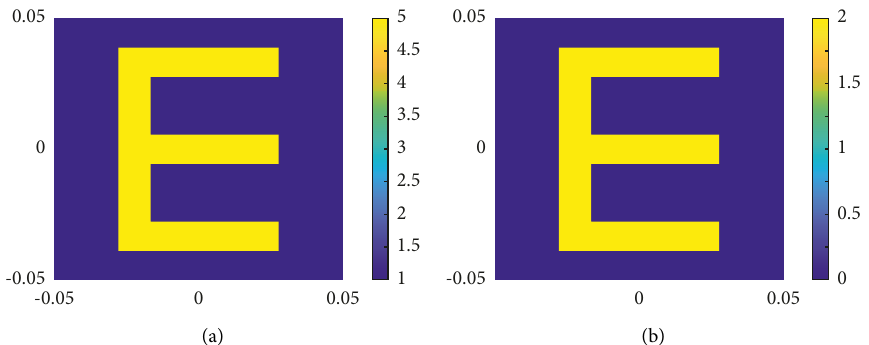
Figure 10: Inversion results of relative permittivity distribution. (a) Real part. (b) Imaginary part.